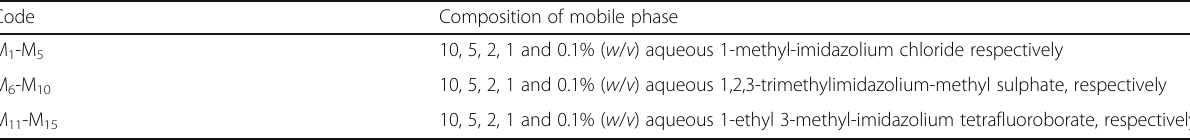
Table 1 The composition details of mobile phases